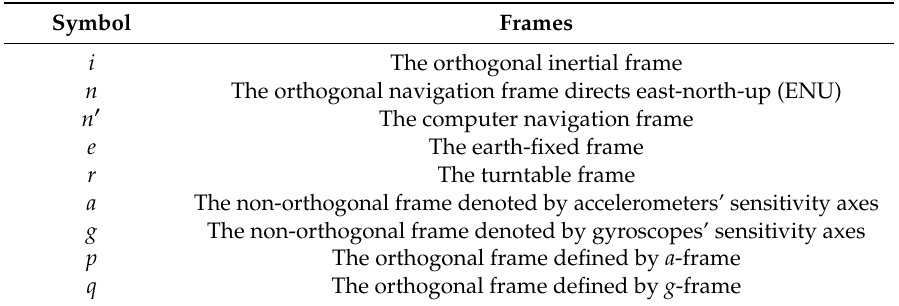
Table 1. The definition of frames.